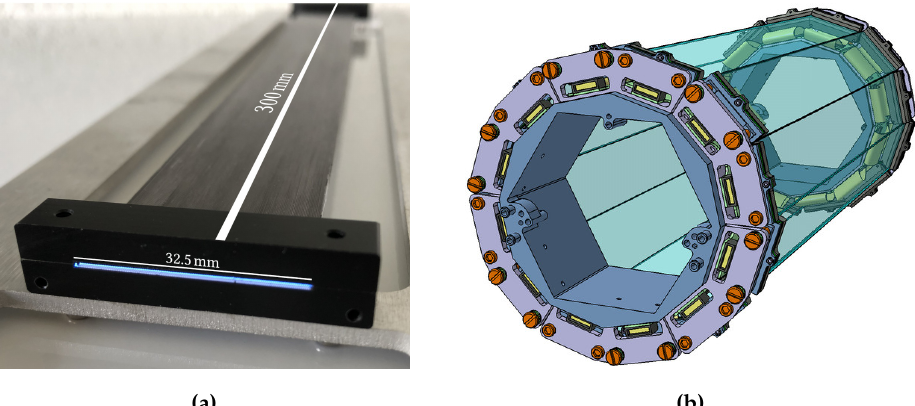
Figure 10.17: Sag of the SciFi ribbon as a function of the temperature for dierent values of the applied spring ten- sion.